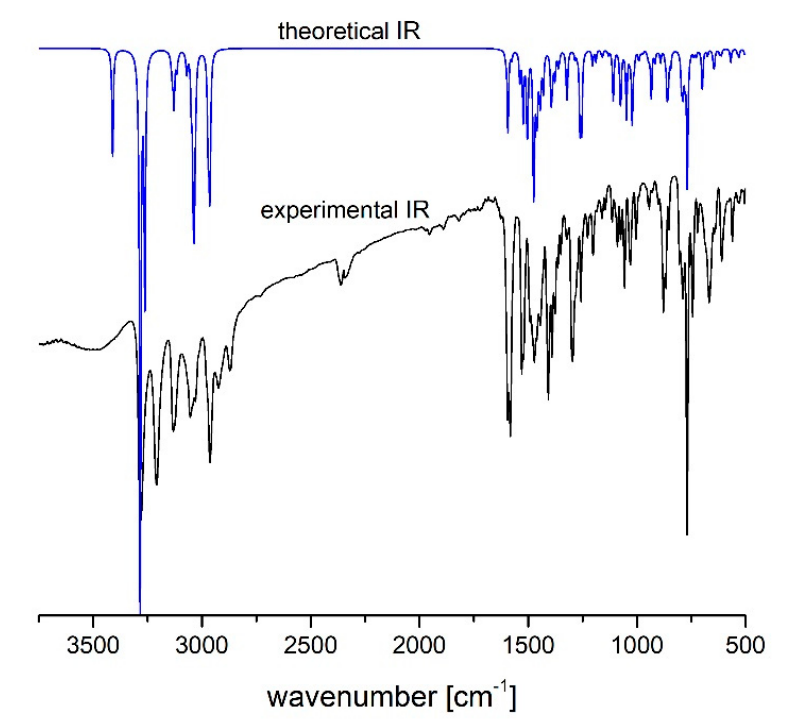
Figure 6. The experimental IR spectrum of 1 and theoretical IR spectrum of 2a .